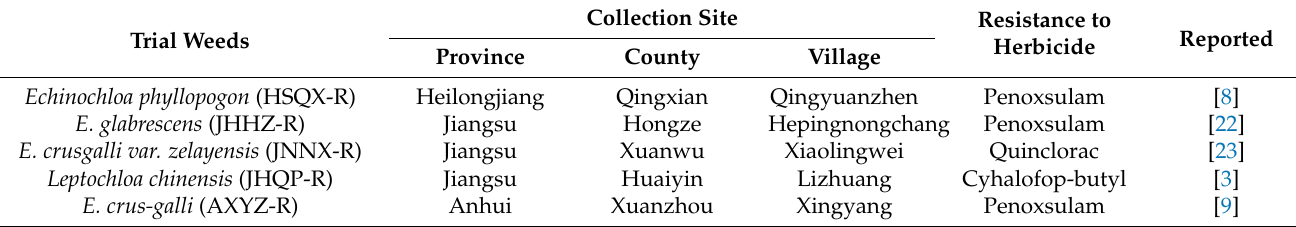
Table 2. Collection location and resistant seed